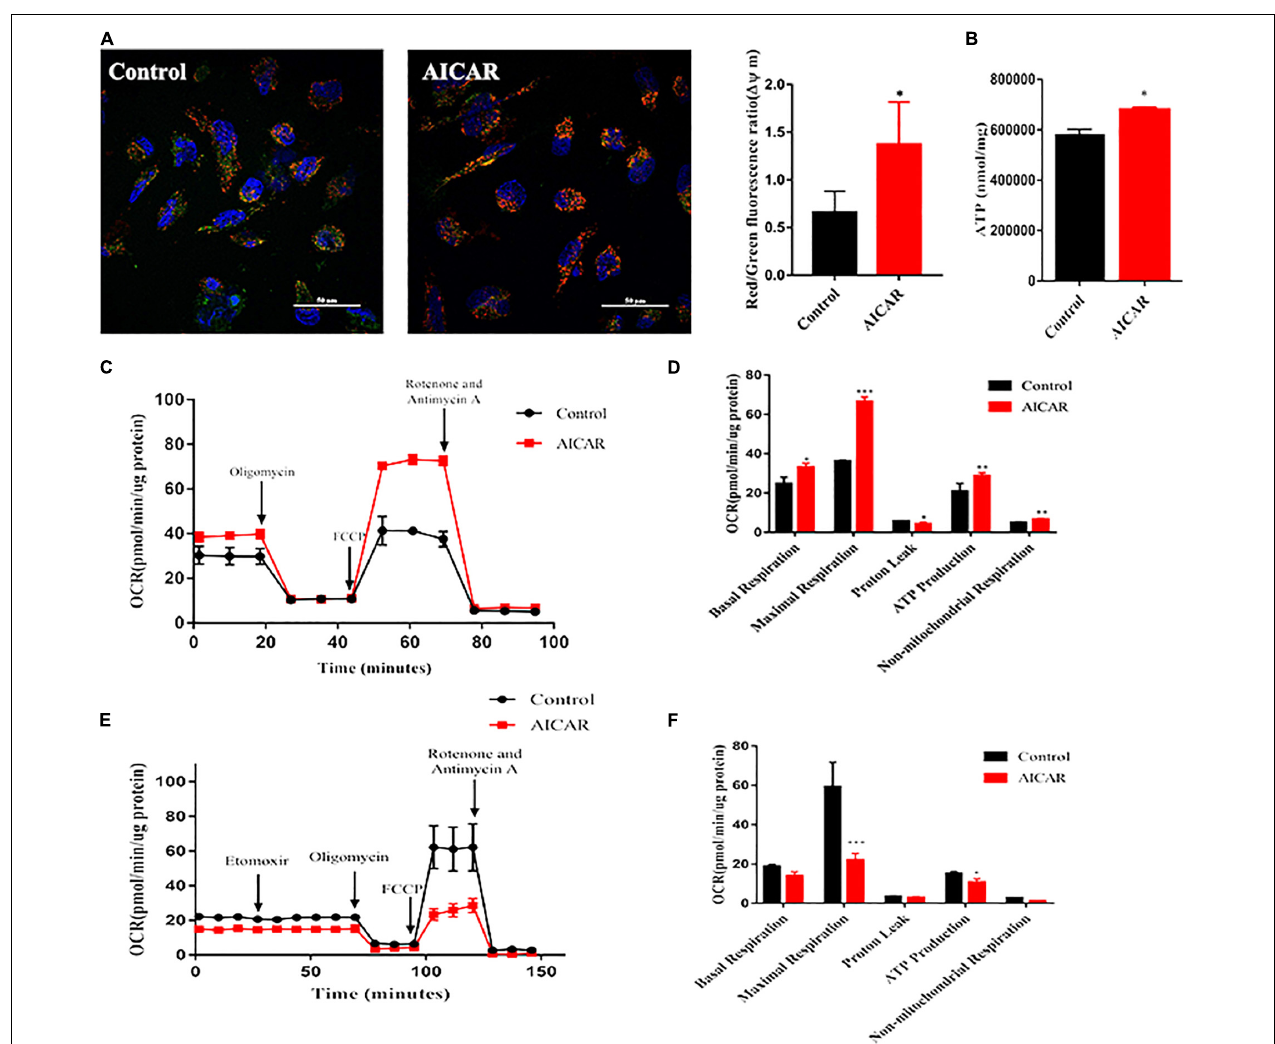
FIGURE 6 | Activation of AMPK improves the functional maturation of mitochondria in hiPSC-CMs. (A) Mitochondrial membrane potential was measured using a fluorescence probe JC-1 assay system in hiPSC-CMs treated with AICAR vs. control. The ratio of red/green fluorescence represents the level of (cid:49) ψ m ( n = 80–100 cells/group). Scale bar, 50 µ m. (B) ATP levels of hiPSCs treated with AICAR or control ( n = 3). (C) Two representative OCR traces of hiPSCs treated with AICAR or control in response to oligomycin, FCCP, rotenone, and antimycin A ( n = 12). (D) Statistical analysis of the differences in basal respiration, maximal respiration, proton leakage, ATP production, and non-mitochondrial respiration ( n = 12). (E) Representative fatty acid oxidation of hiPSCs treated with AICAR or control after incubation with the etomoxir, oligomycin, FCCP and rotenone, and antimycin A. (F) Statistical analysis of the differences in basal respiration, maximal respiration,